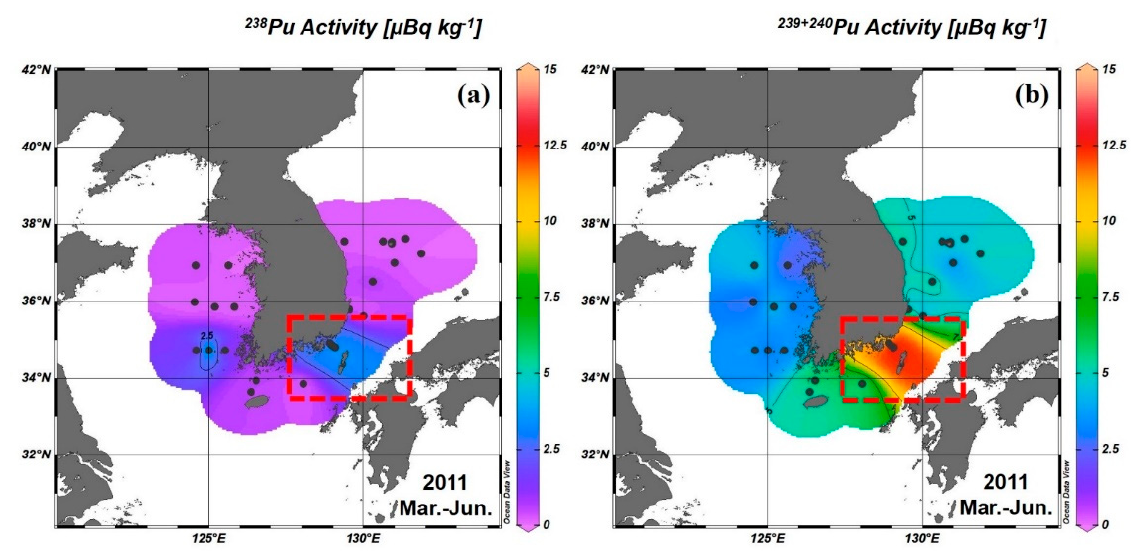
Figure 4. The spatial distributions of: ( a ) 238 Pu; and ( b ) 239+240 Pu and activities. The red square indicates the region (Korean Strait) where the samples (data) were collected on 29–30 March 2011 (same region as in Figure